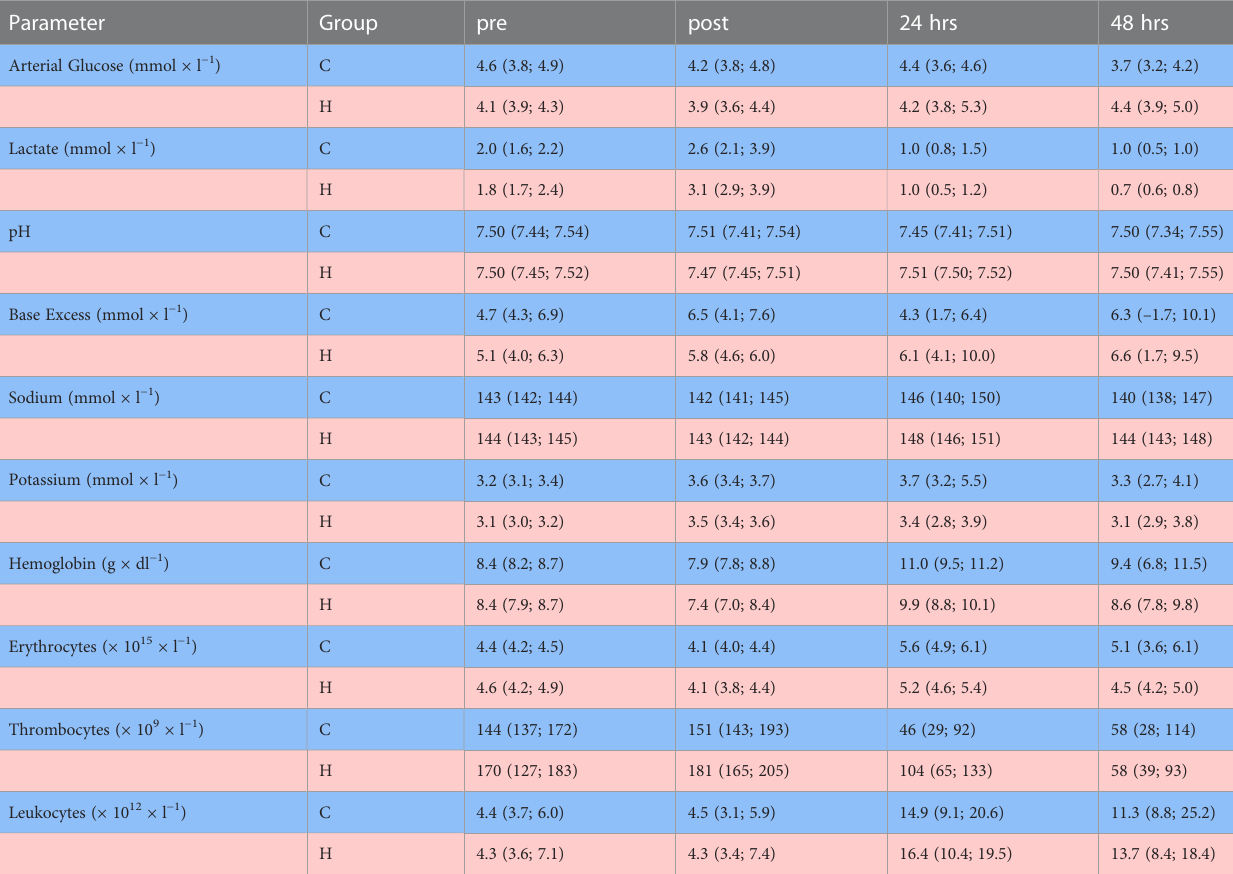
TABLE 2 Glucose, lactate, pH, base excess, and complete blood count before (pre) and after 2 hrs of hemorrhagic shock and acute subdural hematoma (post) as well as 24 hrs and 48 hrs after resuscitation.